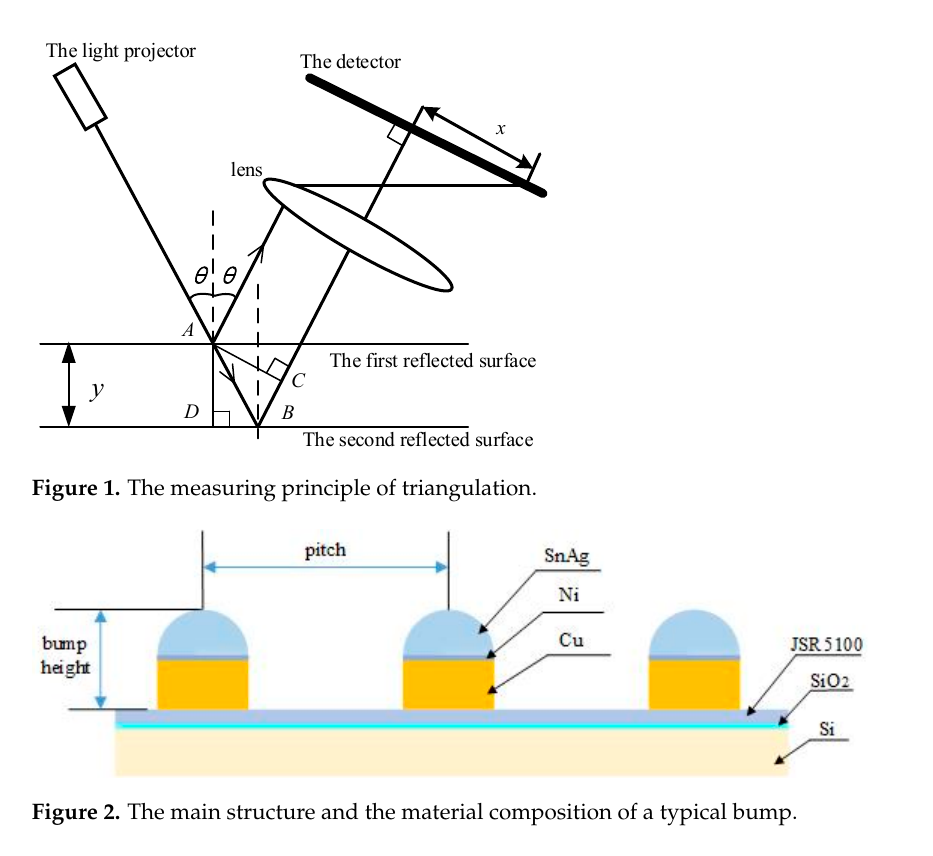
Figure 2. The main structure and the material composition of a typical bump.